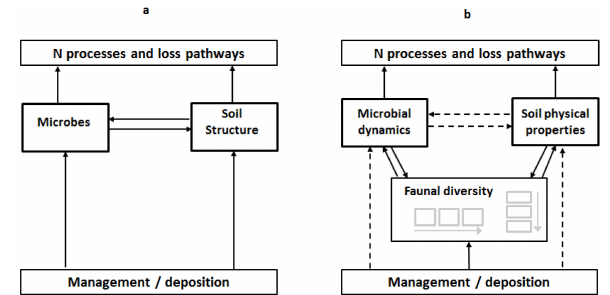
Figure 4. The influence of soil fauna on soil N processes and loss pathways. Conventionally (a) , these processes and loss pathways were often considered as the result of interactions between microbes and soil structure. More recently (b) , it is recognized that many mi- crobial and physical properties are influenced by faunal diversity through trophic relationships and through changes in the soil struc- ture by ecosystem